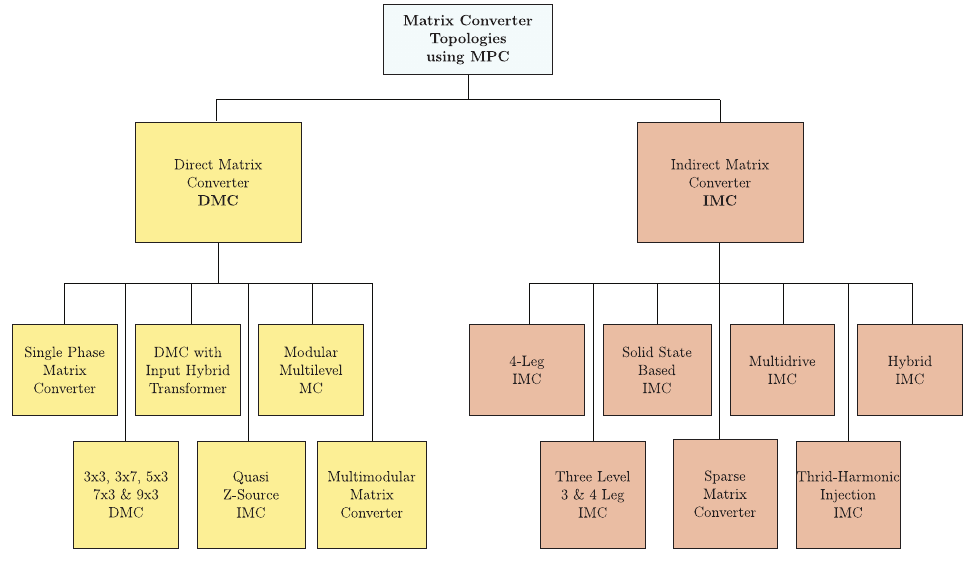
Figure 15. Classification of matrix